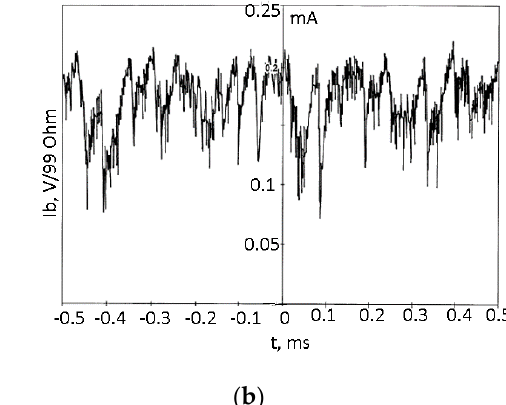
Figure 4. ( a ) Separated 11 B + ion beam current Ib vs. arc current Id for (2) SAS, and (1) Bernas ion source. ( b ) Oscillogram showing the degree of beam noise; note the current scale.